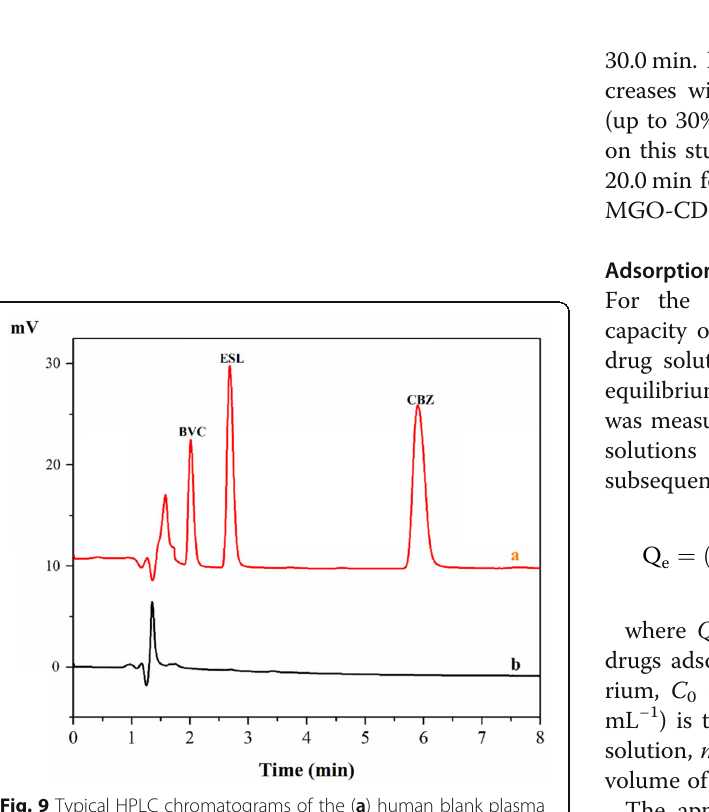
Fig. 9 Typical HPLC chromatograms of the ( a ) human blank plasma sample after the extraction and ( b ) spiked sample solution after extraction with SPE at a low-level